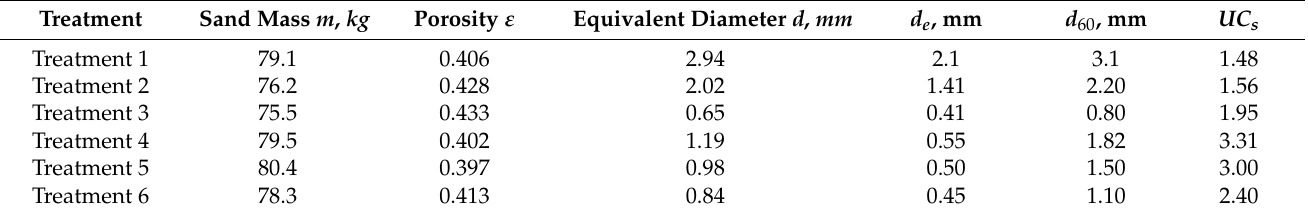
Table 1. Quartz sand parameters in the gradation treatment.